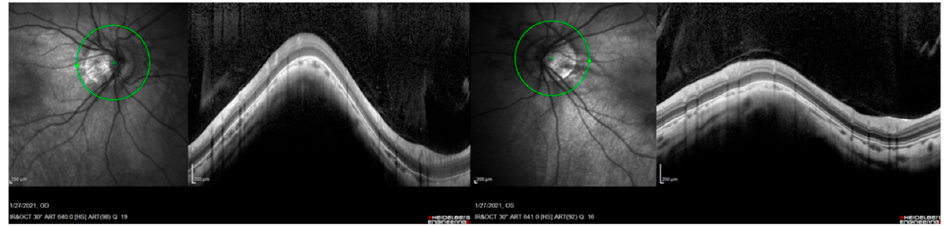
Figure 3. Optic nerve OCT with peripapillary atrophy, from left to right, OD and OS. Patient from family OFT-0047.